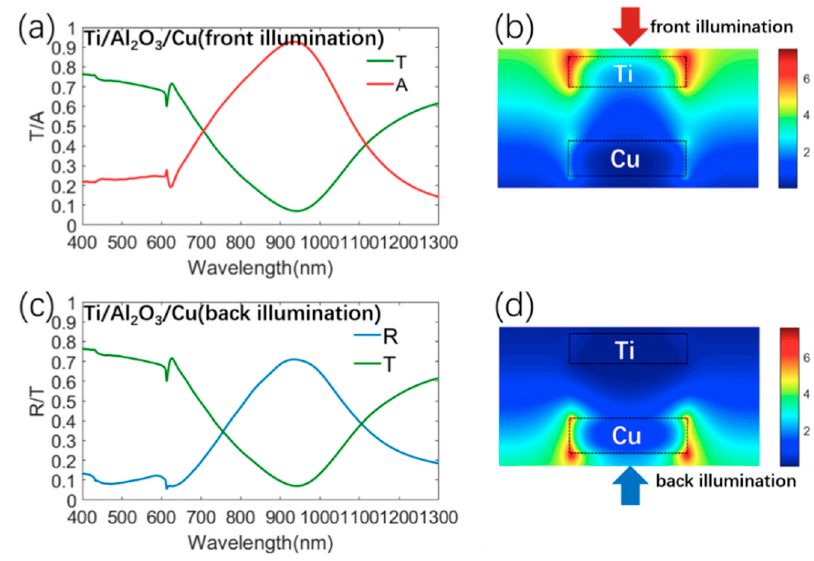
Figure 5. ( a ) Simulation absorption/transmission spectra of the metasurface consisting of Ti/Al 2 O 3 /Cu structure for front illumination, and ( b ) distributions of the electric field E at the resonant wavelength of 913.5 nm. ( c ) Simulation reflection/transmission spectra of the metasurface consisting of Ti/Al 2 O 3 /Cu structure for back illumination, and ( d ) distributions of the electric field E at the resonant wavelength of 913 nm.